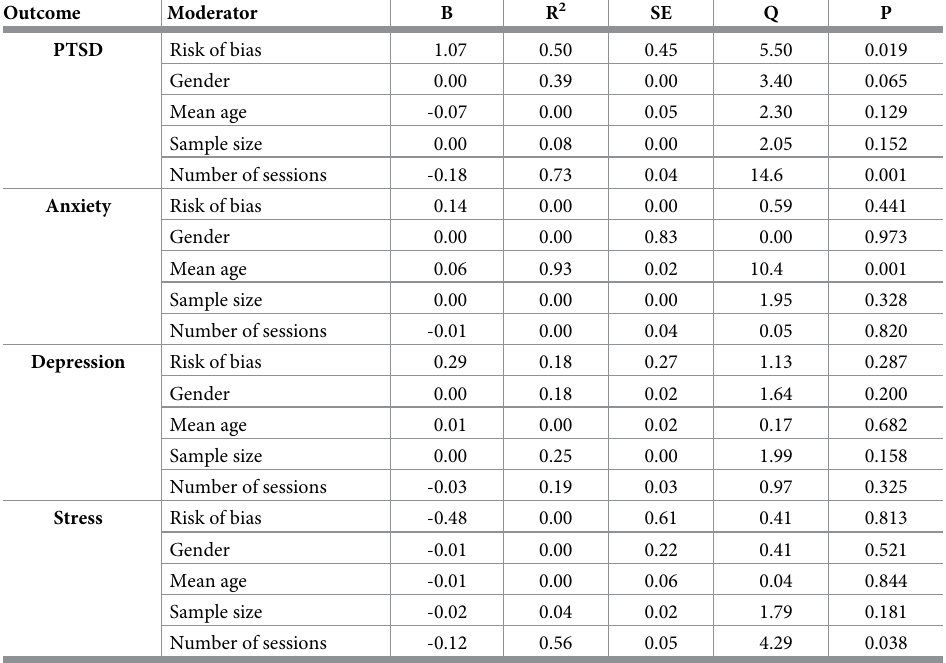
Table 3. Meta-regression analyses relating to sample size, risk of bias, number of sessions, and the total length of intervention minutes. Outcome